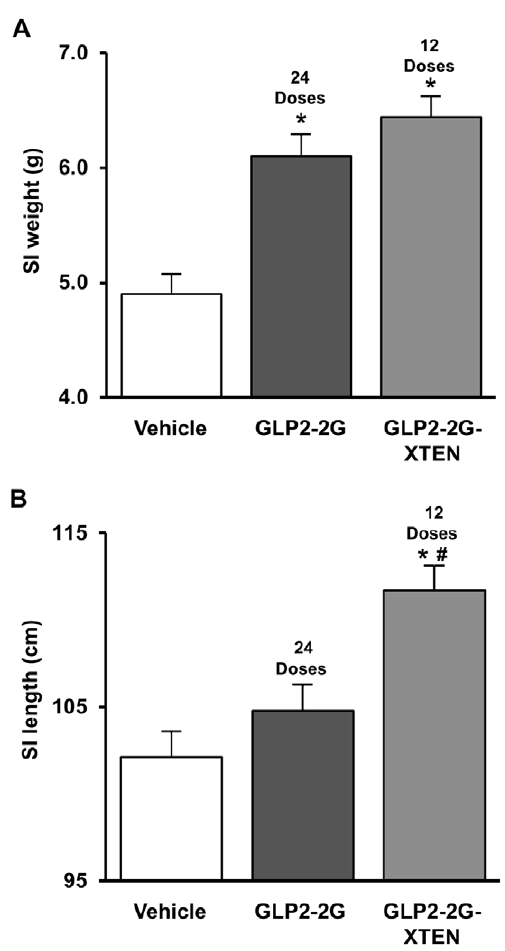
Figure 3. Intestinotrophic effects of GLP2-2G peptide and GLP2-2G-XTEN. Small intestine weight A) and length B) in normal rats following treatment with a total dose of 300 nmol/kg GLP2-2G peptide or GLP2-2G-XTEN. Data shown are from day 12 following SC injection of GLP2-2G peptide (12.5 nmol/kg per injection; twice per day for 12 days) and GLP2-2G-XTEN (25 nmol/kg per injection; once per day for 12 days). Data are means and SE, n=10 per group. * P , 0.05 compared to vehicle-treated rats, # P , 0.05 compared to GLP2-2G peptide treated rats.